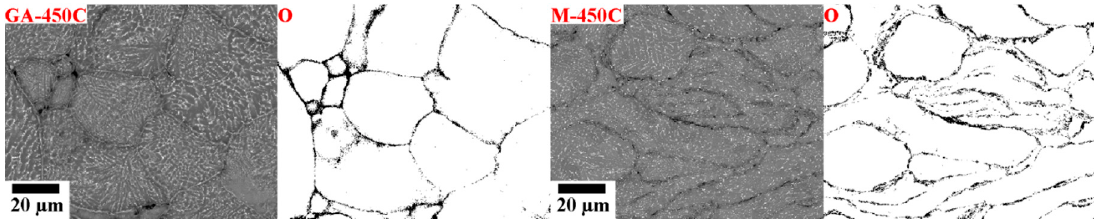
Figure 5. SEM micrographs of GA-450C and M-450C samples and the corresponding oxygen EDX.